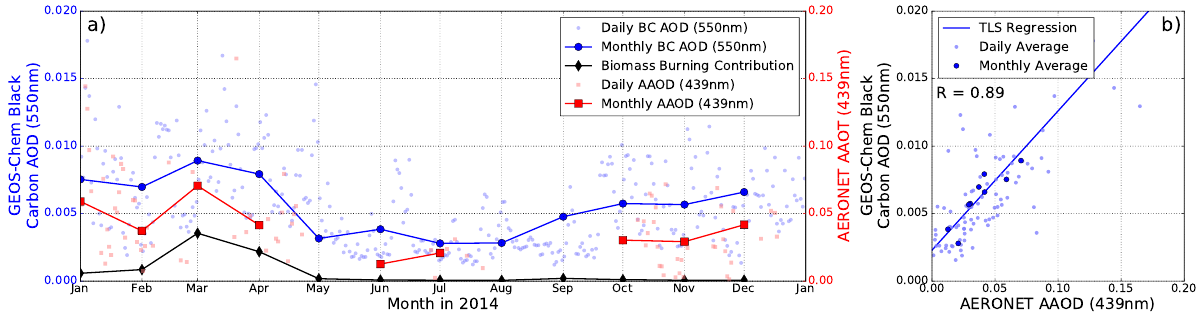
Figure 2. (a) Time series of the GEOS-Chem simulation of black carbon aerosol optical depths (AODs) and the sun photometer observation of aerosol absorption optical depths over Hong Kong. The contribution of black carbon AODs originating from biomass burning sources is also shown for reference. (b) Comparison of GEOS-Chem simulation of black carbon AODs and sun photometer observation aerosol absorption optical depths over Hong Kong. Daily and monthly average data are shown. The total least squares regression line is calculated based on the monthly average data.